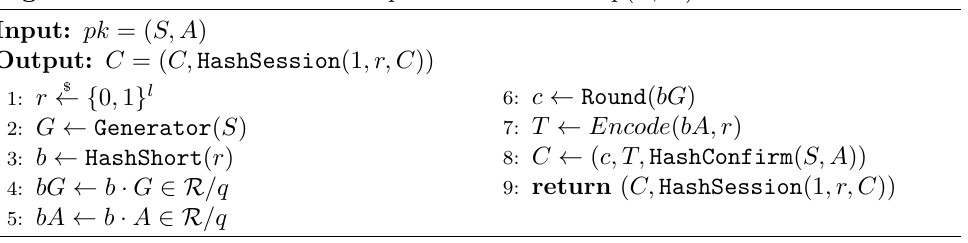
Algorithm 5 NTRU LPRime Encapsulation: LPREncap( S , A )